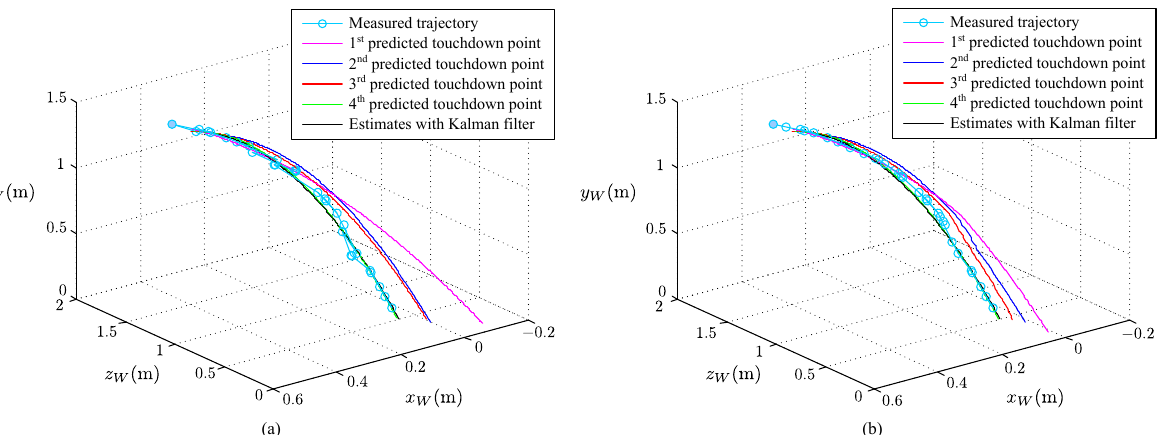
Figure 22. Prediction of touchdown points: ( a ) the previous work and ( b ) this study.